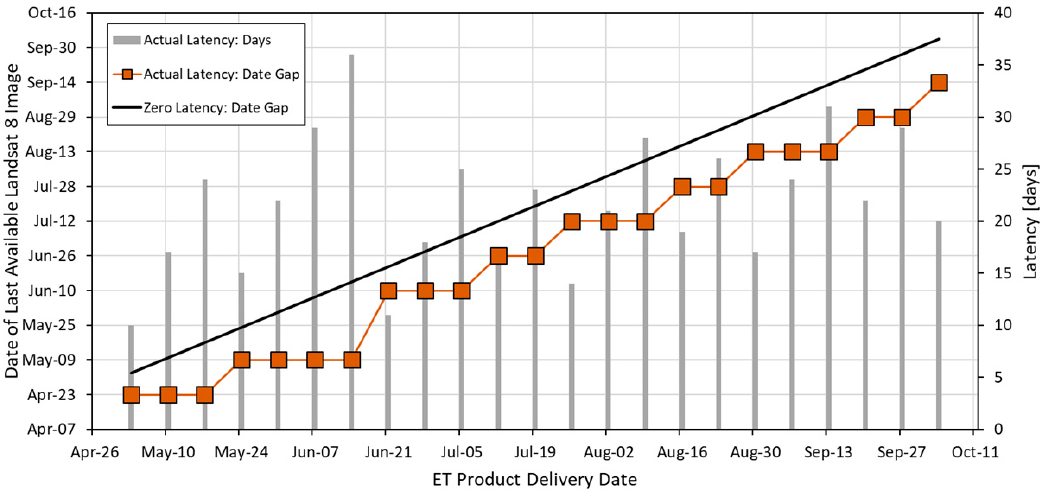
Figure 2. ET product delivery date (x-axis) and the corresponding date of last available Landsat 8 T1 image (y-axis, orange square). Latency (second y-axis; gray bars) represents the number of days between the ET product delivery date and date of last available Landsat 8 T1 image. One to one line indicates hypothetical zero latency between ET product delivery date and Landsat 8 T1 image.